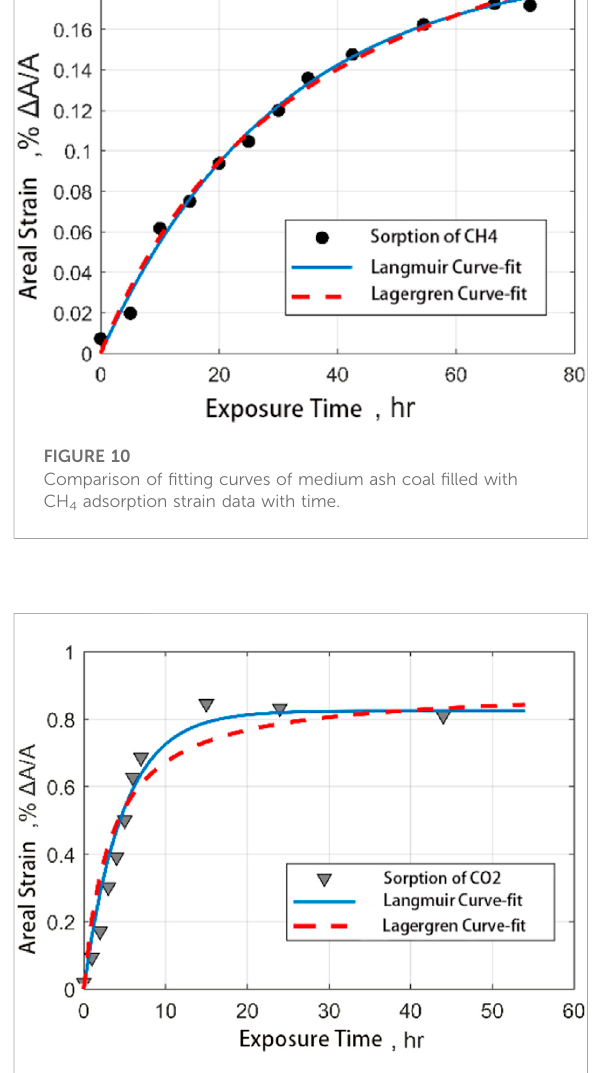
FIGURE 11 Comparison of fi tting curves of ash coal fi lled with CO 2 adsorption strain data with time.